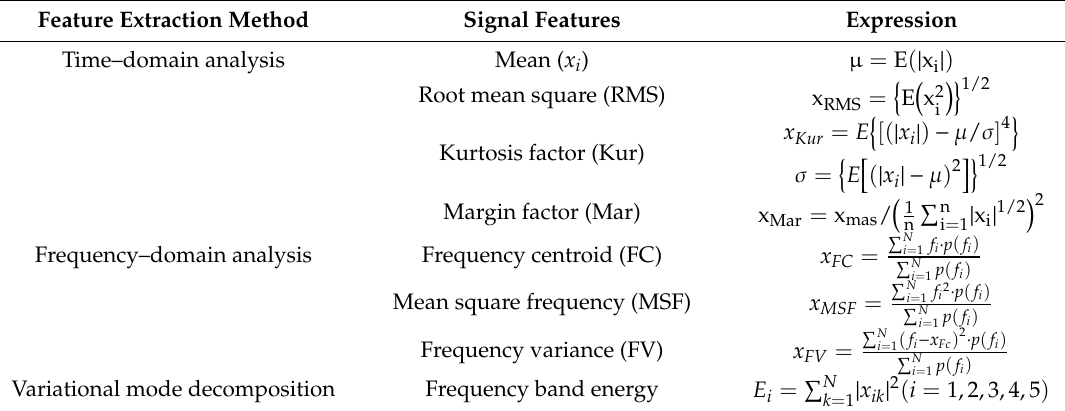
Table 2. List of extracted